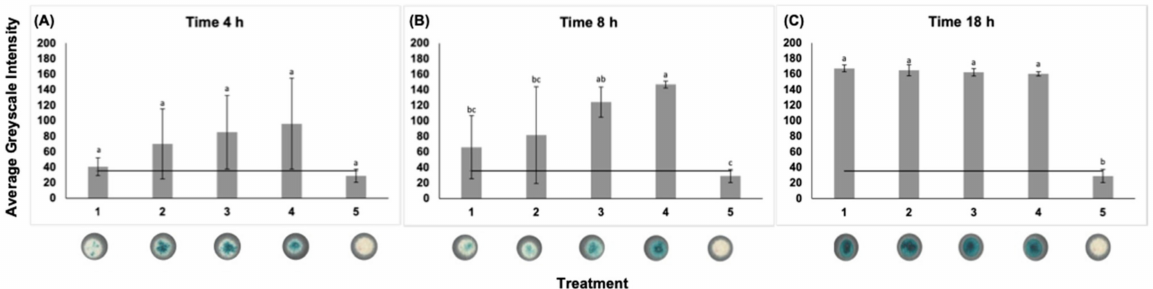
Figure 3. LOD and TTD for the development of a test specific for the detection of Listeria spp. The average greyscale intensity was determined using ImageJ. The threshold value is represented in black. Bars show standard deviations of three means. Means with different letters are significantly different. Digitized colorimetric images. Representative wells are depicted. ( A ) time 4 h, ( B ) time 8 h, ( C ) time 18 h. From left to right on the x-axis are the following treatments: (1) L. monocytogenes 1